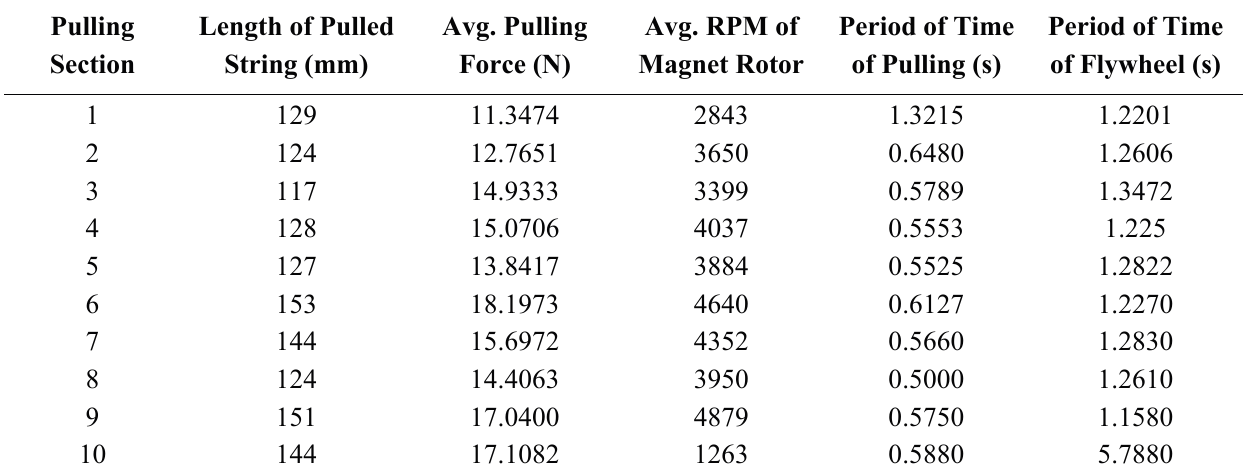
Table 3. The measured performance of the prototype generator.